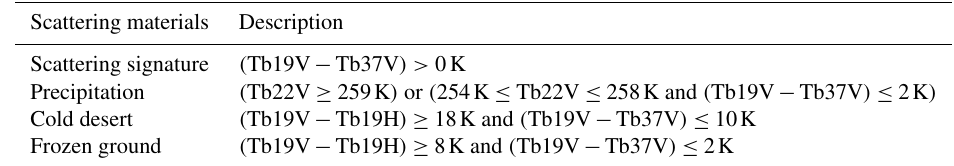
Table 2. The description of the revised Grody’s algorithm. The unit is Kelvin (K). Scattering